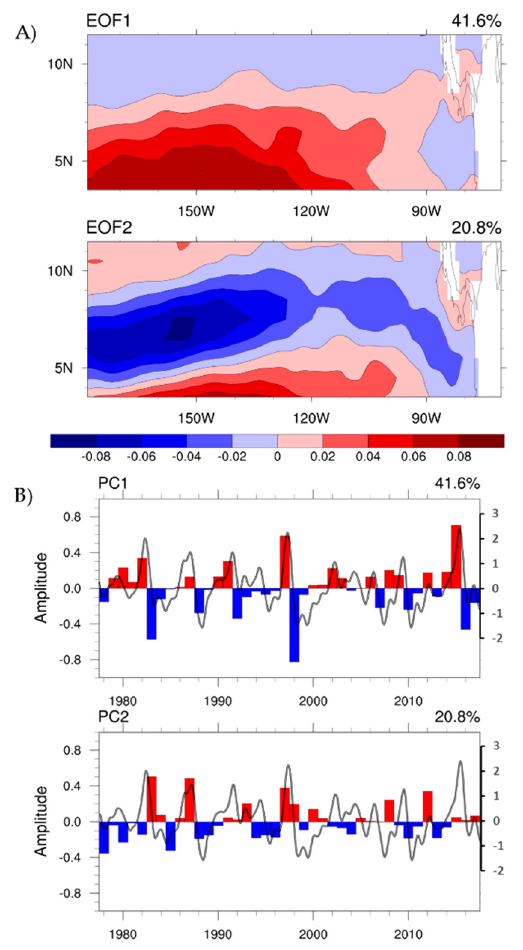
Figure 2. Two leading EOF analyses of the zonal component of surface current for summer (JJA): ( A ) spatial pattern and ( B ) time series of the principal component superimposed with 6 months low-pass filtered NIÑO 3.4 index. Red and blue bars represented the NECC’s strengthening and weakening, respectively.